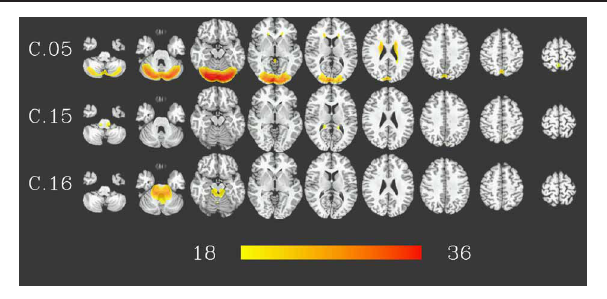
FIGURE 3 | Artifact components consistent in 1000 resting-state datasets. Results are presented as t -values, thresholded at t 999 = 18 ( p = 1 . 6 · 10 − 57 , FWE-corrected), each row corresponding to one component showing nine representative slices spaced 15mm in z direction. Red color represents highest t -values, images are shown in radiological convention (the right side of the brain is displayed on the left). Color bar shown for t -values between 18 and 36